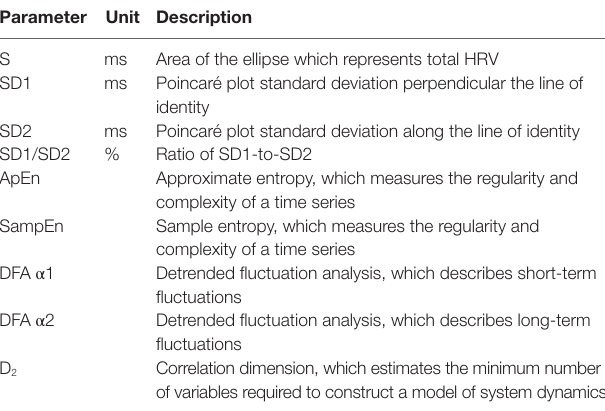
TABLe 3 | HRV non-linear measures. Parameter Unit